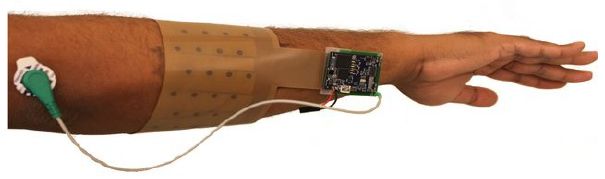
Figure 7. Wireless EMG + accelerometer acquisition device